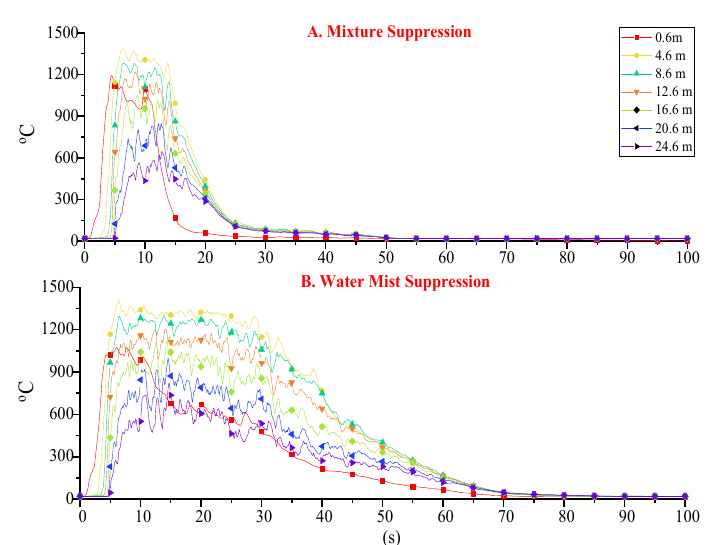
Figure 15. Temperature obtained by thermocouples placed above the nozzle at a vertical distance of each thermocouple at z = 0.6, 4.6, 8.6, 12.6, 16.6, 20.6, 24.6 m with effective extinguishing after suppression. ( A ) Mixture suppression, ( B ) water mist suppression.